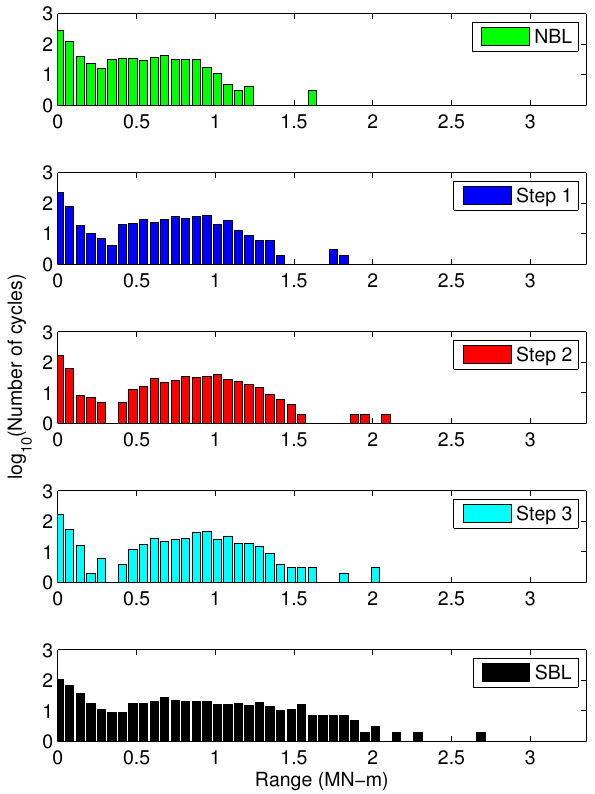
Figure 13. Comparison of TTYM range histograms for a single case (control).